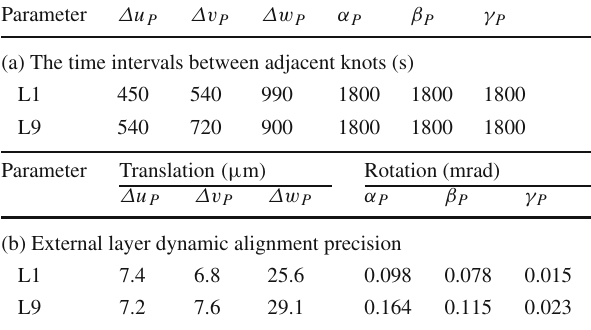
Table 4 (a) The time intervals between adjacent knots used for the spline smoothings of the individual alignment parameters that provide (b) the best dynamic alignment